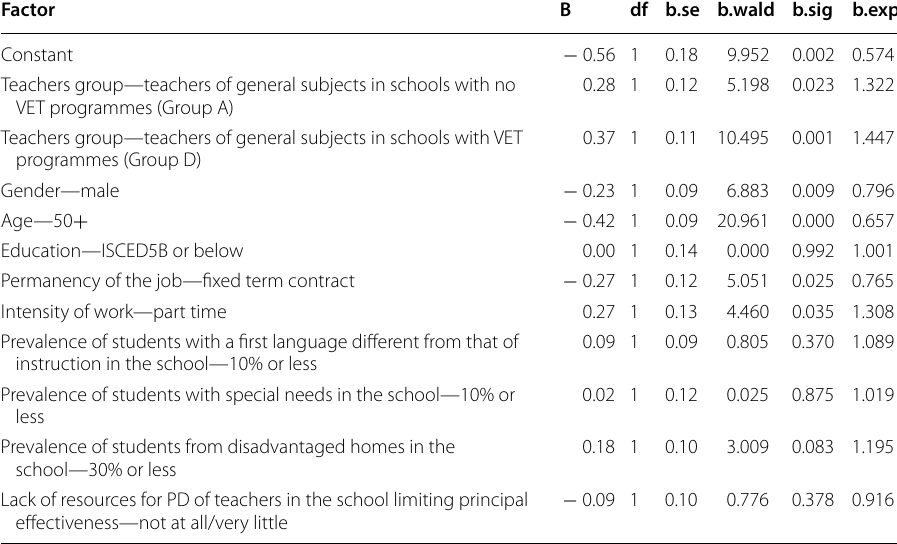
Table 21 Declaring family responsibilities as a barrier to professional development, results of the logistic regression model, regressors R1–R10, Italy, 2013 (Source: Author’s calculations based on OECD, TALIS